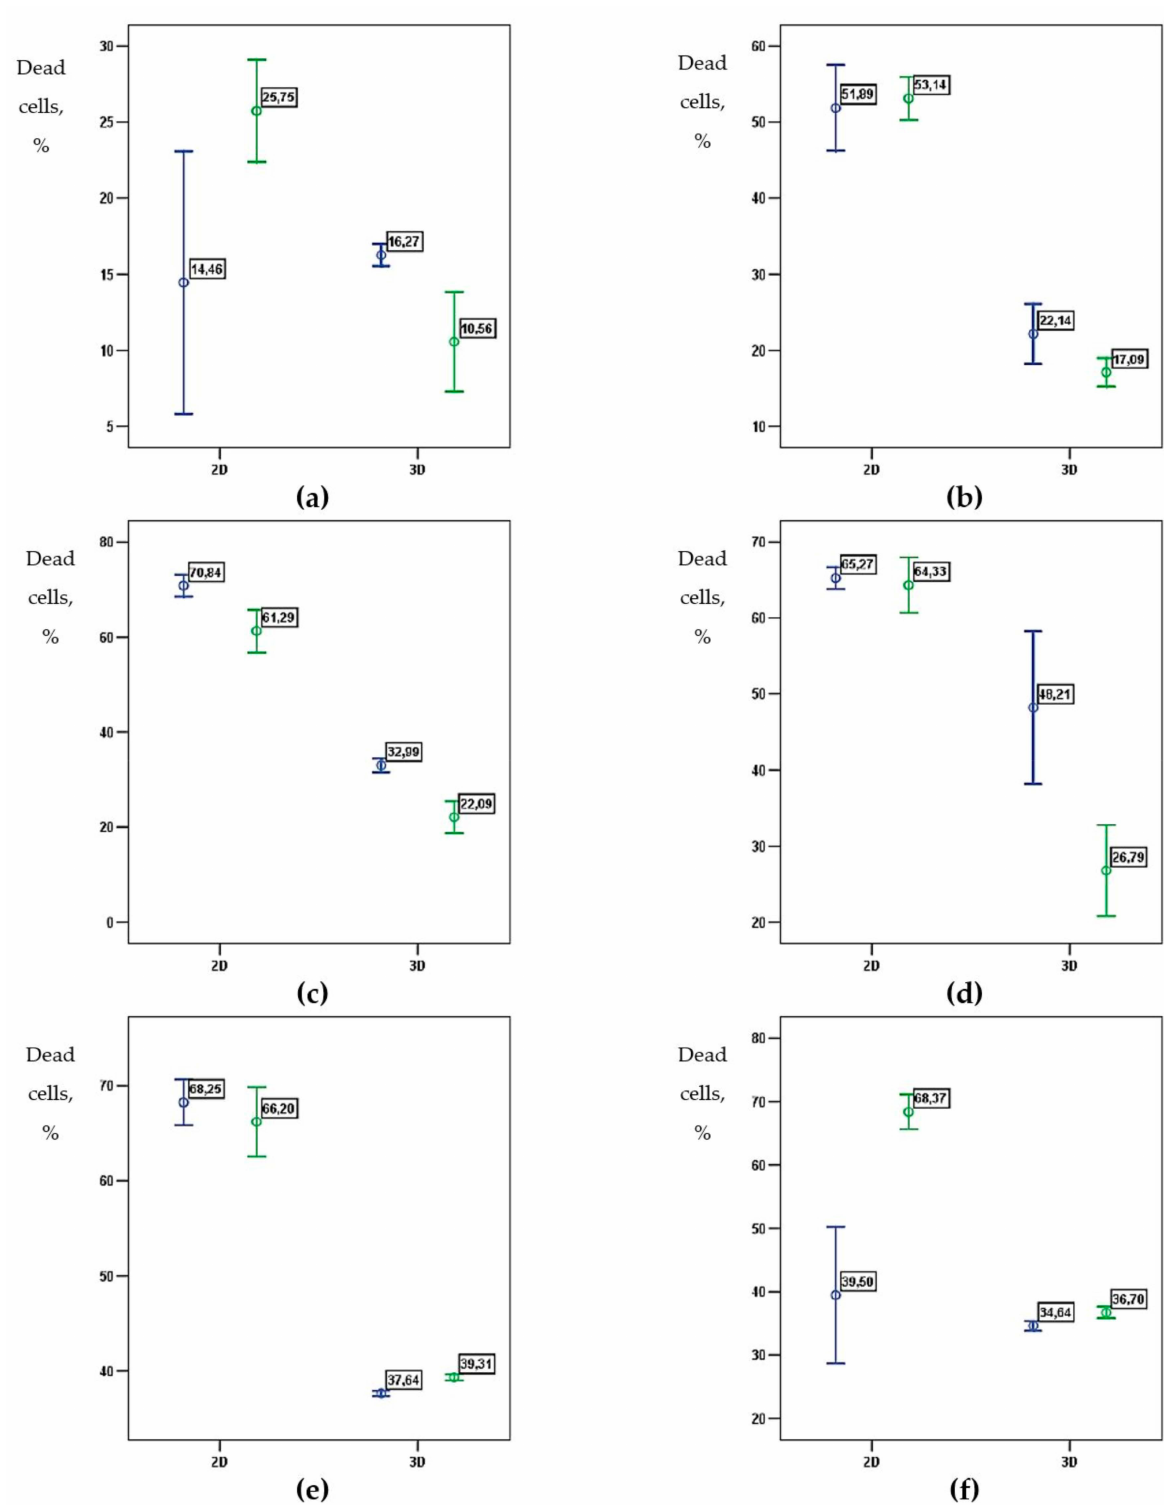
Figure A21. Intergroup comparisons of the cytotoxic effect of free and nanoformulated Dox in the 2D culture of MDA-MB- 231 cells and 3D TECs after 36 h exposure. The mean ratio of dead cells after application of free Dox (blue) and AMS-6-Dox (green), respectively, is shown for the following concentrations of Dox: ( a ) 0.1 µ g/mL; ( b ) 1 µ g/mL; ( c ) 3 µ g/mL; ( d ) 5 µ g/mL; ( e ) 7 µ g/mL; and ( f ) 10 µ g/mL. Error bars show 95% confidential intervals for the mean percent of dead cells. Data labels on the graphs also indicate the mean percentage of dead cells in the